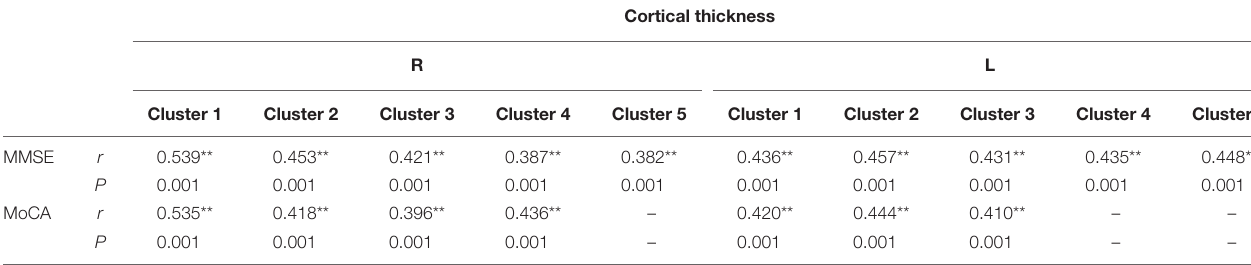
TABLE 4 | Correlation between cortical thickness and MMSE and MoCA scores.